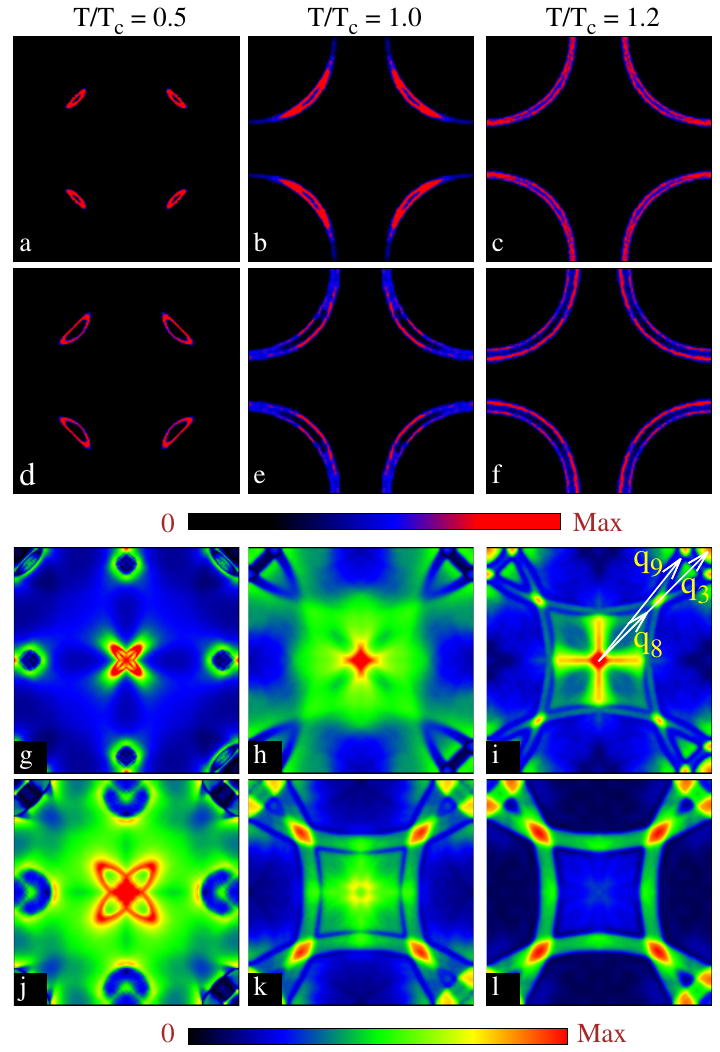
Figure 3: Evolution of quasiparticle spectral function A ( k , ω ) for ω = (a-c) 0.15 t and (d-f) 0.3 t as a function of temperature. k directions, respectively, with each having range [ - π , π ] . Corresponding QPIs for ω = (g-i) 0.15 t and (j-l) 0.3 t